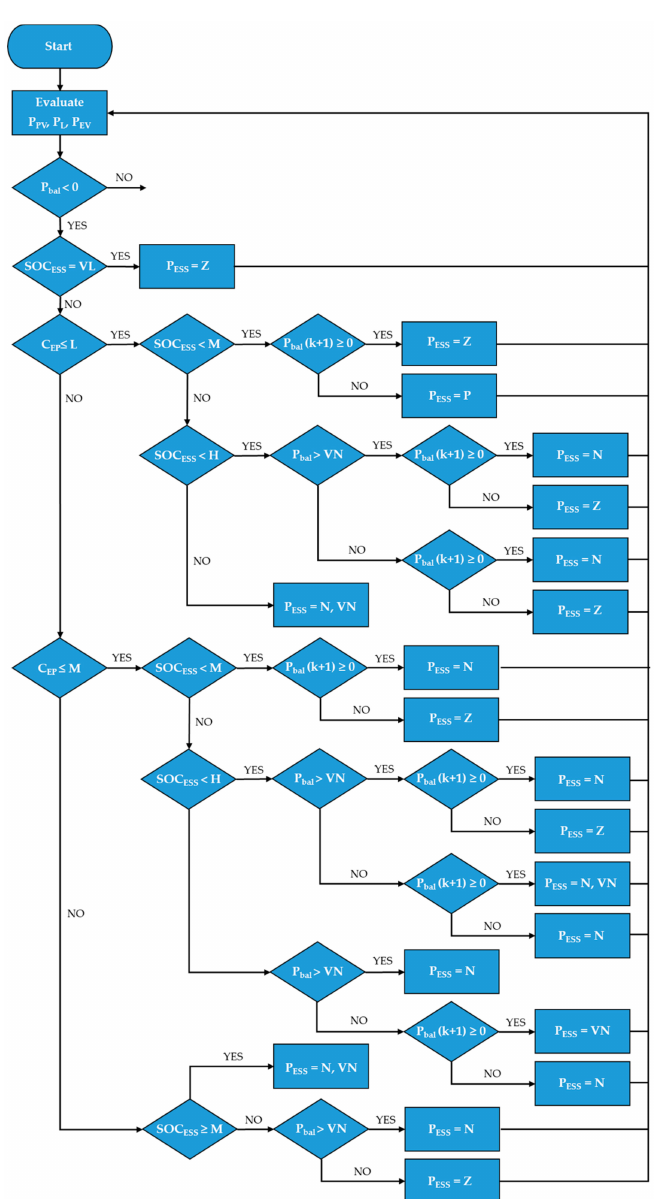
Figure 8. FLC1 flowchart diagram in the sampling k when there is an energy deficit situation (VL: Very Low, VN: Very Negative, L: Low, N: Negative; Z: Zero; M: Medium, H: High; P: Positive, VP: Very Positive, VH: Very High; according to membership functions defined in Figure 5). It